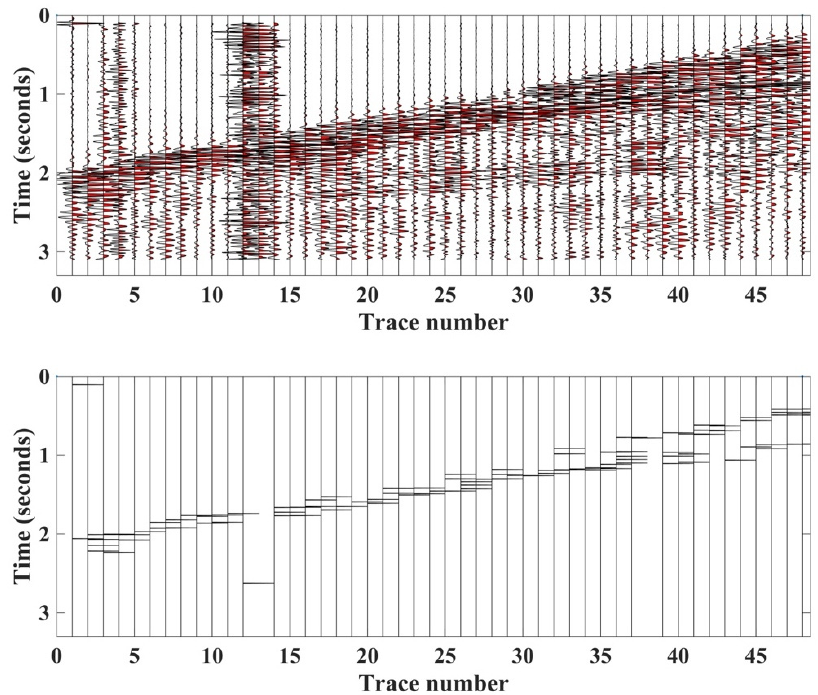
Figure 13. Yilmaz record number 23 ( top ) and the estimated picks using the HEEH method ( bottom ).